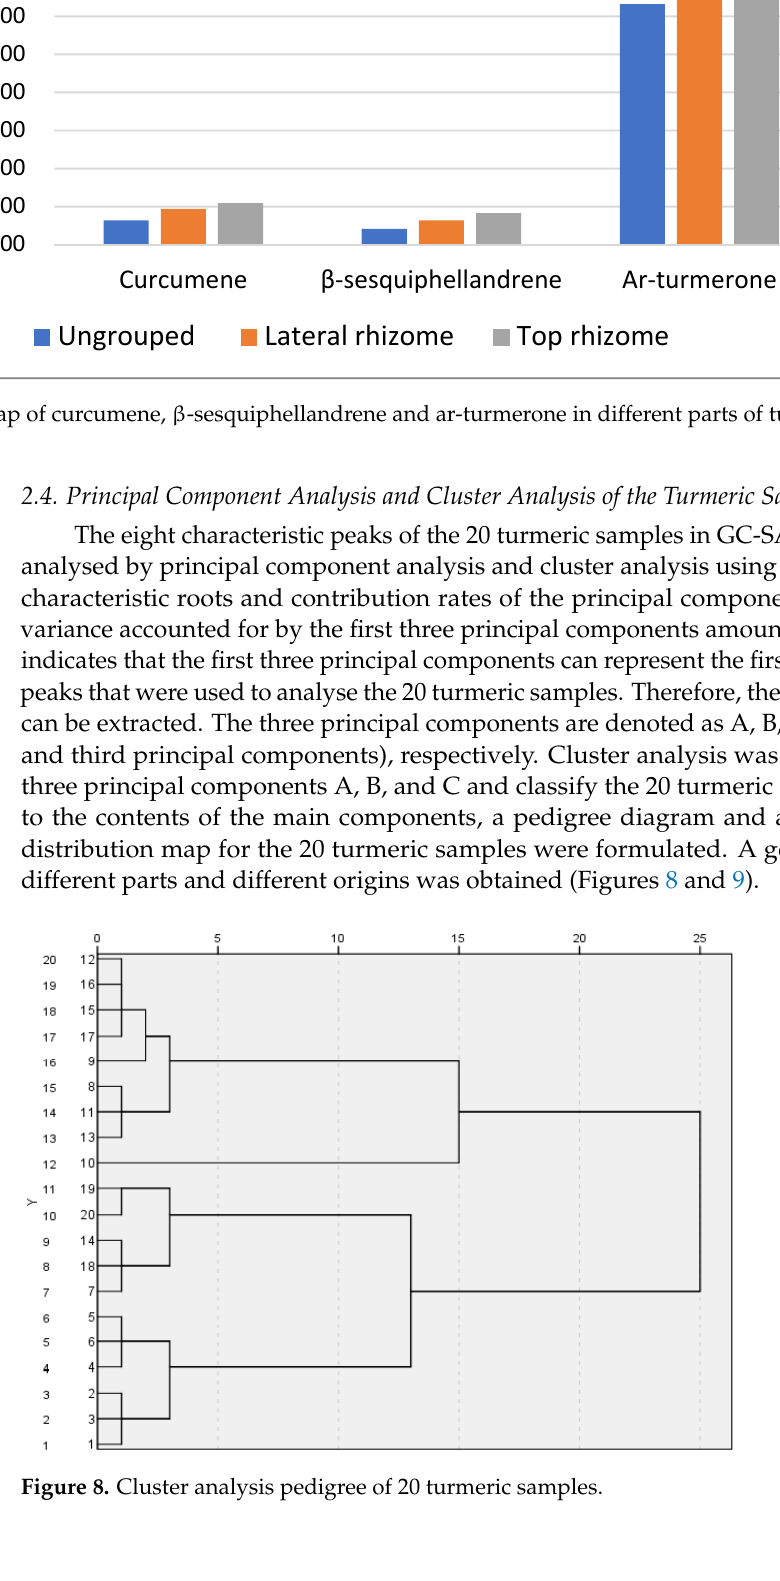
Figure 9. Three-dimensional distribution map of 20 turmeric samples. The 20 turmeric samples were divided into four categories (Table 3). The first cate- gory was the lateral rhizome and top rhizome turmeric from Lotus Pond Market 3. The second was the lateral rhizomeand top rhizome of turmeric from Yin-an Village and Lotus Pond Market 1. The third was the top rhizome of turmeric, mainly from Lotus Pond Mar- ket 2, Zhagu, Tielu Town, and Lotus Pond Market 1. The fourth was ungrouped turmeric from Myanmar, Yunnan, Yulin, Tielu Town, Xintang, Shilong, and Baijiawan Village. Table 3. Classification table of 20 groups of turmeric samples. Category